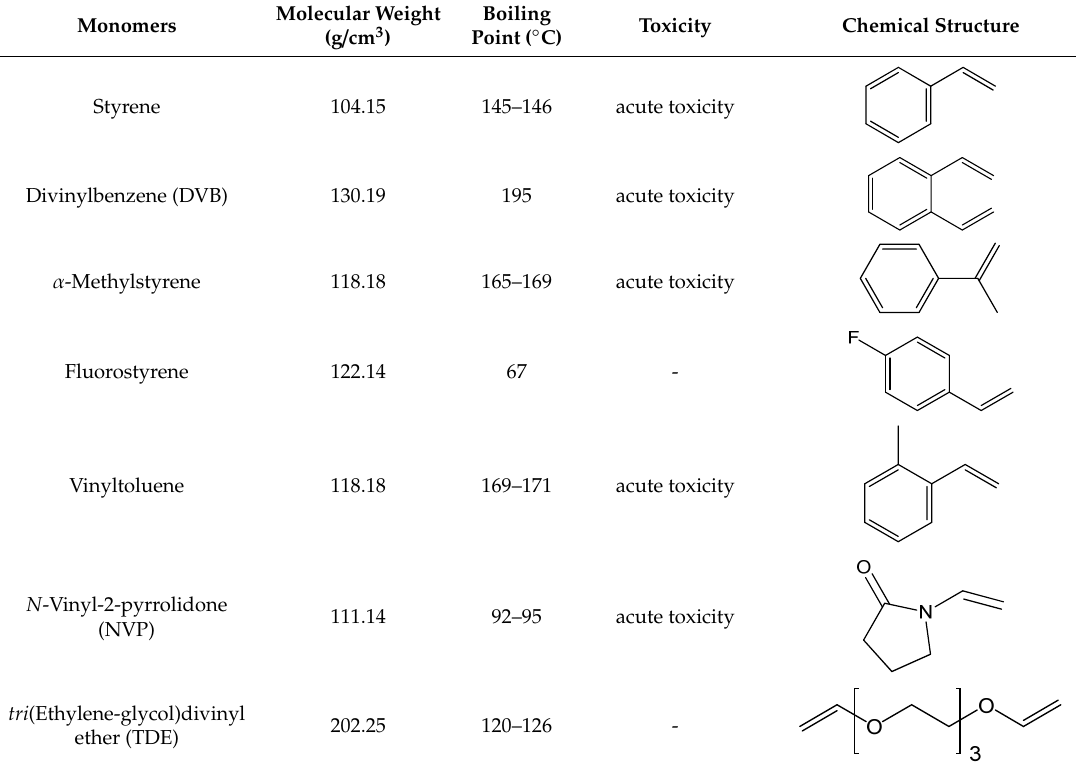
Table 1. Characteristics of commonly used vinyl monomers as reactive diluents (RDs).